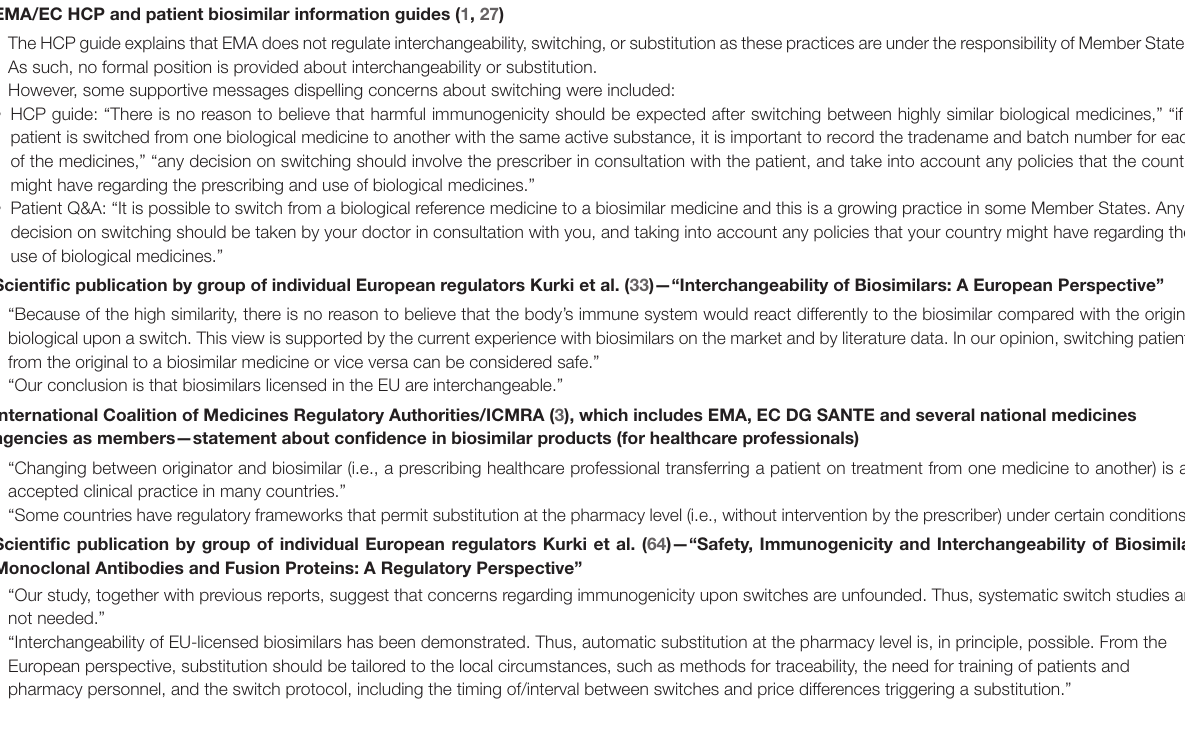
TABLE 2 | Positions about biosimilar interchangeability, switching, substitution by regulators at the European level. EMA/EC HCP and patient biosimilar information guides (1, 27)